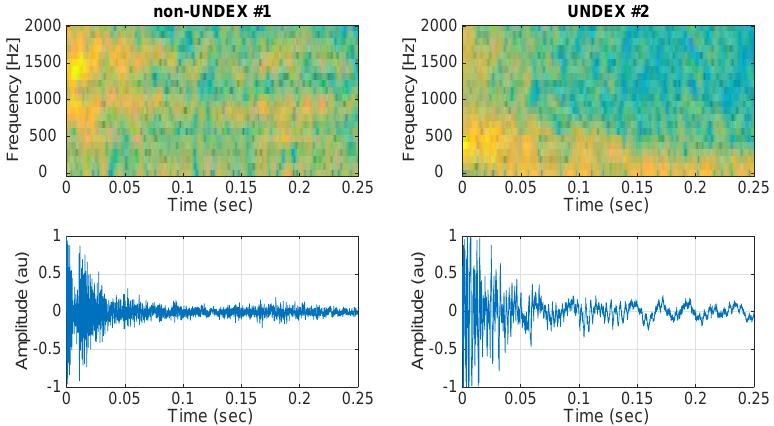
Figure 8. Example of a non-UNDEX event and a real UNDEX event from the database over the duration of the first 0.25